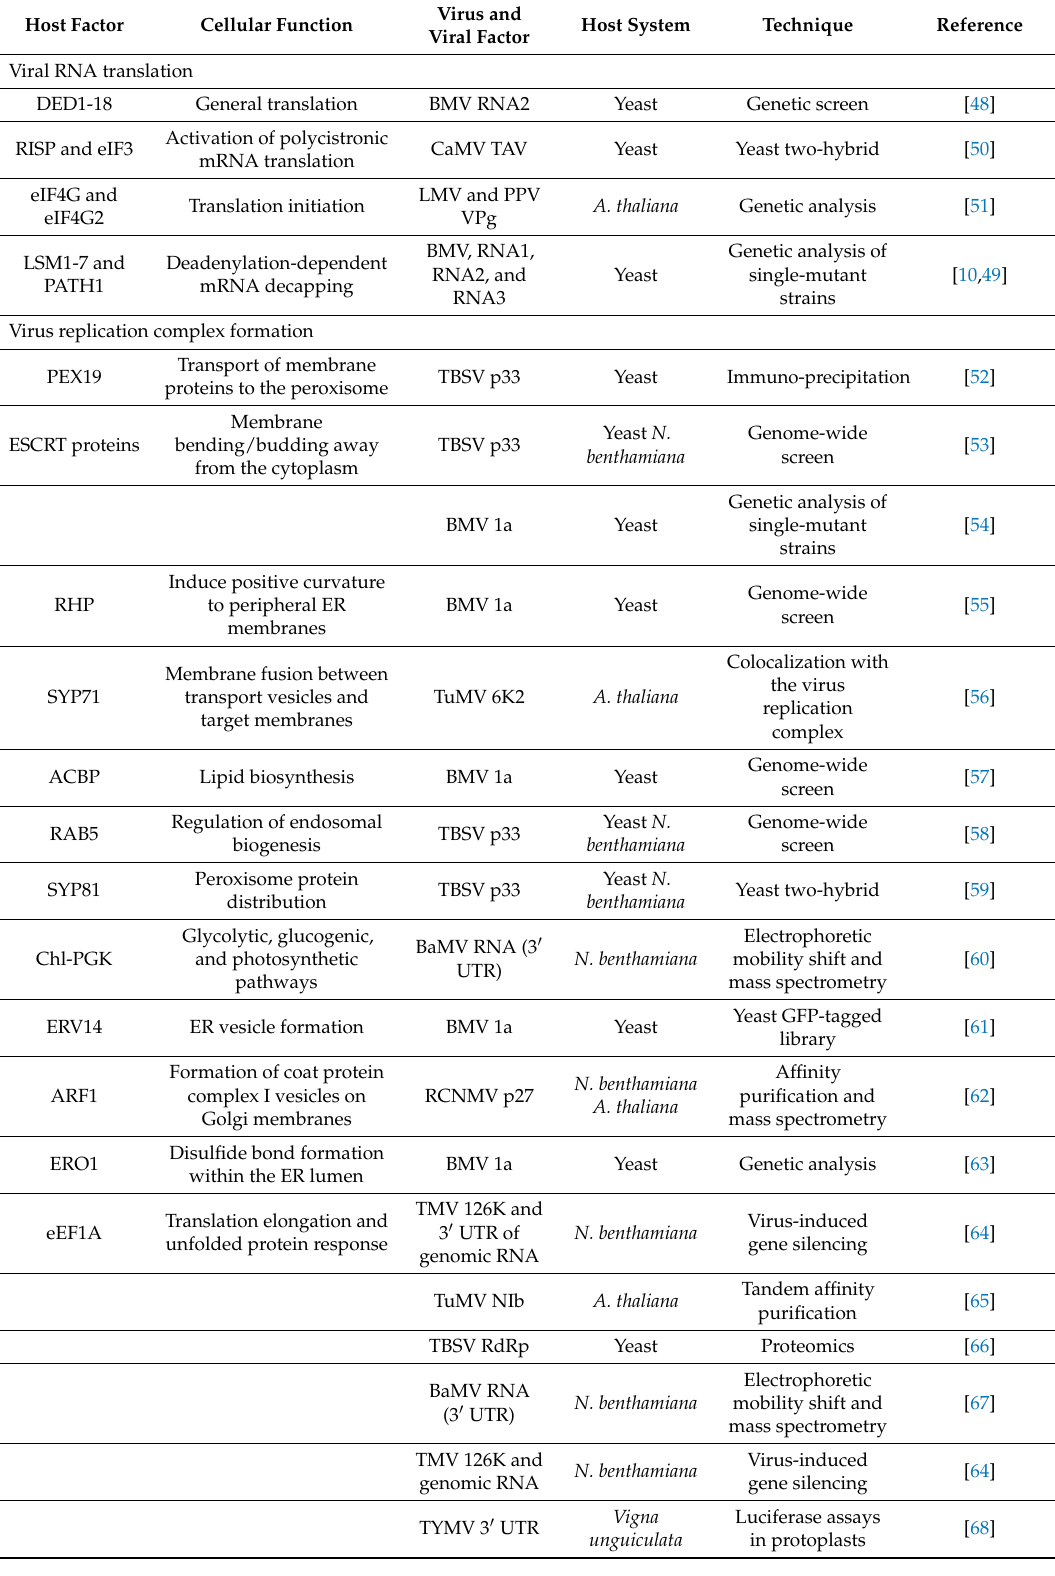
Table 1. Representative nonessential host factors that condition susceptibility to plant